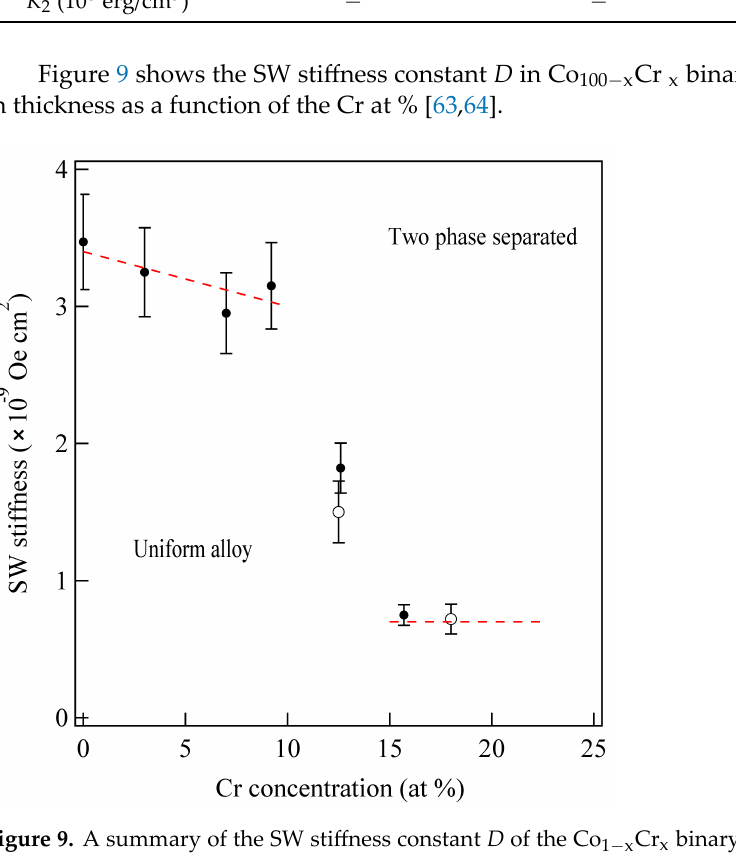
− 9 − 9 Oe · cm 2 and 0.7 × 10 Oe · cm 2 ,